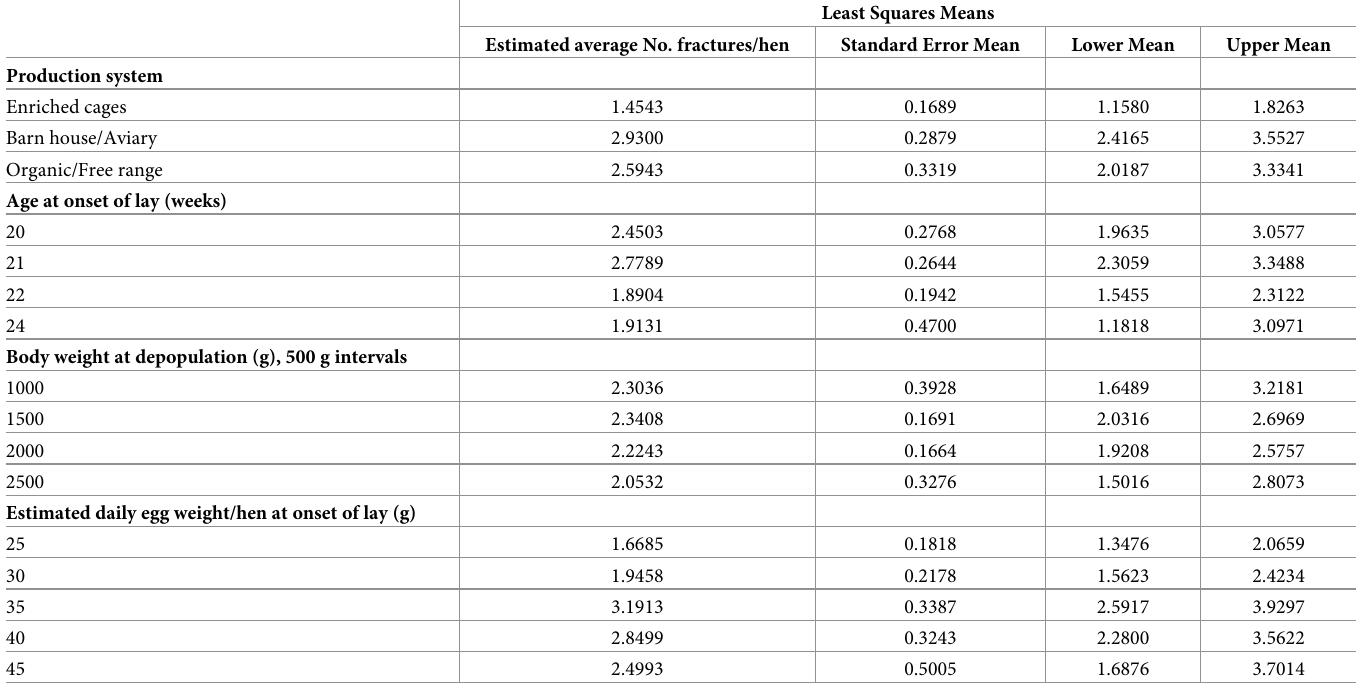
Table 15. Estimated number of KBF per hen (least squares means) for different levels of potential risk